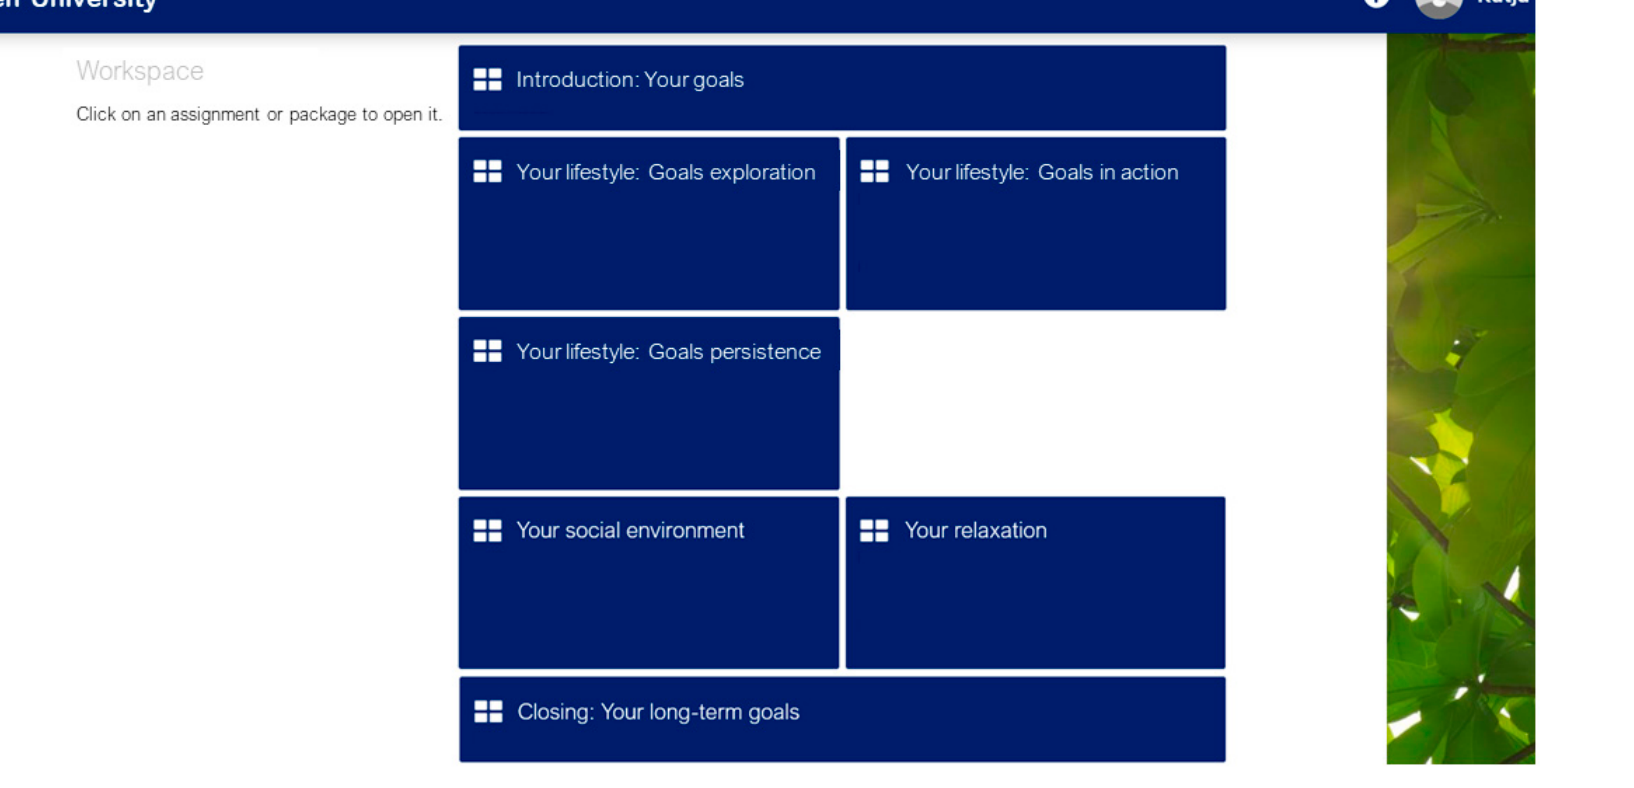
Figure 6. An example of modules in eHealth application “E ‐ coach”.